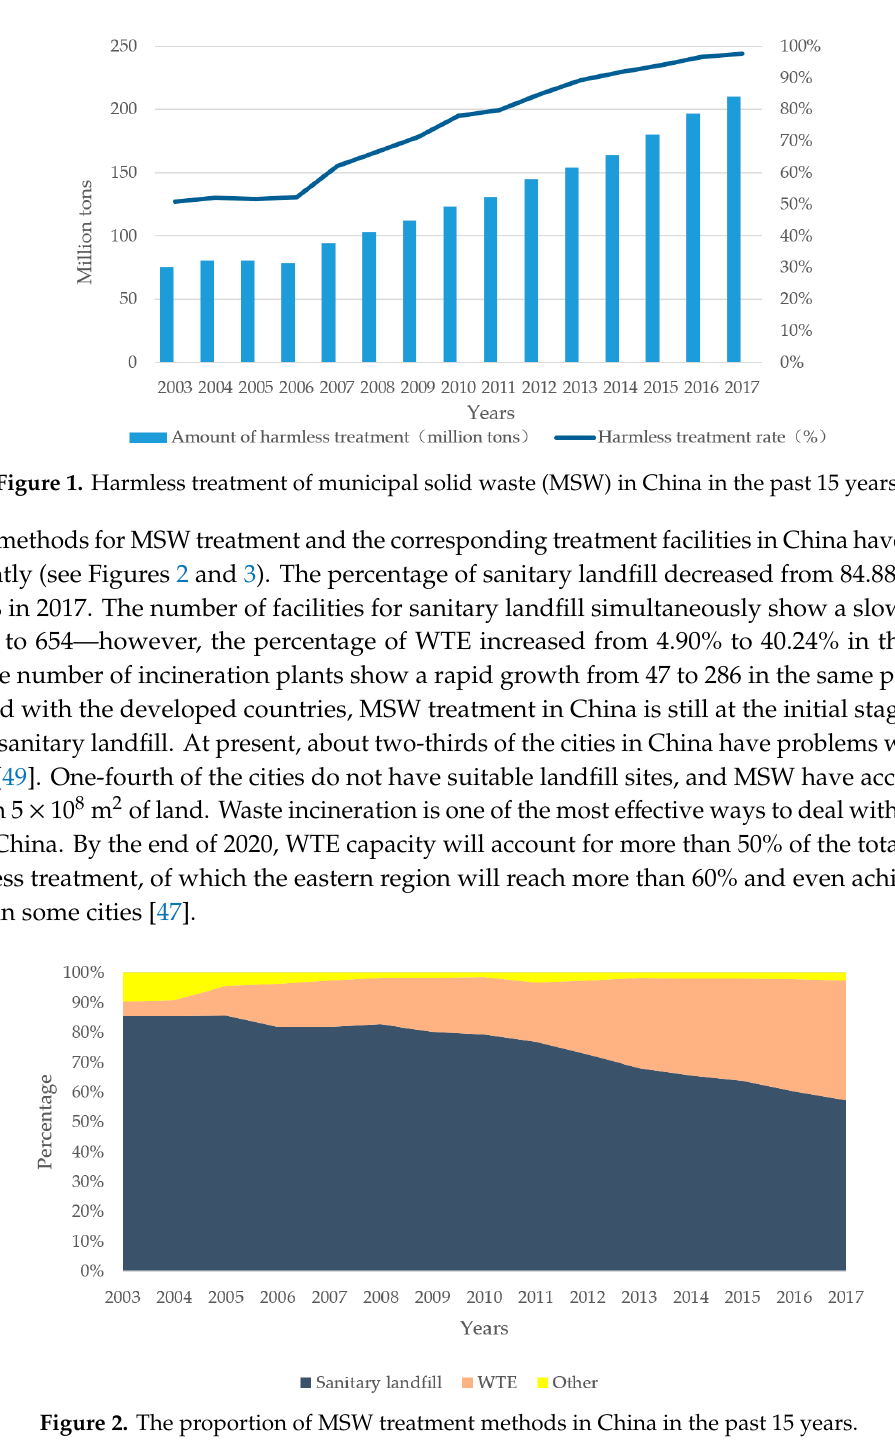
Figure 2. The proportion of MSW treatment methods in China in the past 15 years.